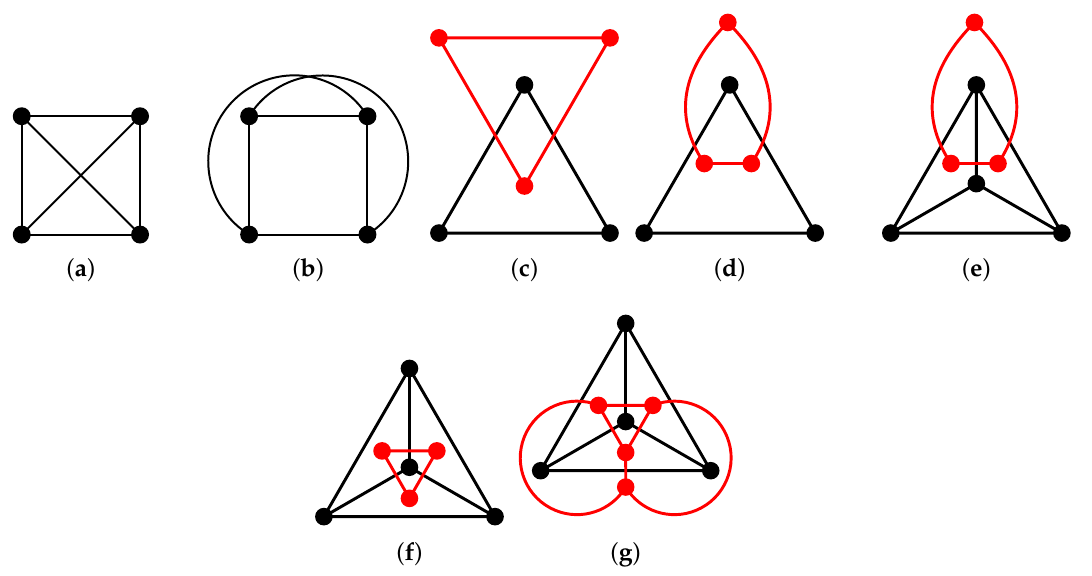
Figure 4. All possible 1-plane graphs involving one or more cliques of type K 3 and K 4 admitting crossings edges. ( a ) and ( b ): two representations of a clique of type K 4 ; ( c ) and ( d ): two representations of two intersecting cliques of type K 3 ; ( e ) and ( f ): two representations of a clique of type K 3 intersecting a clique of type K 4 ; ( g ): two intersecting cliques of type K 4